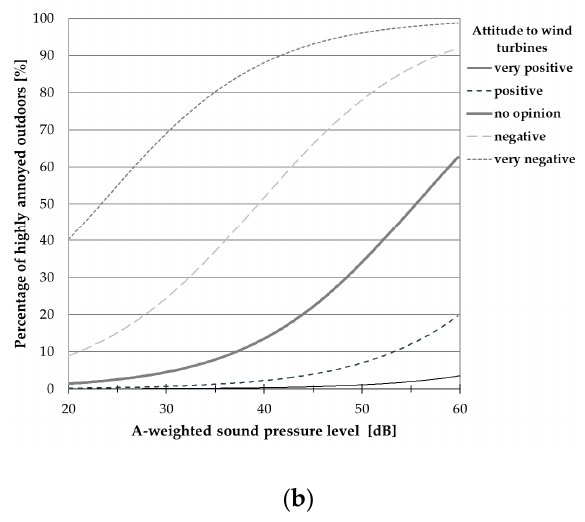
Figure 10. Percentage of respondents being highly annoyed outdoors by the wind turbine noise as a function of attitude to wind farms and ( a ) noise level or ( b ) distance from the nearest wind turbine.